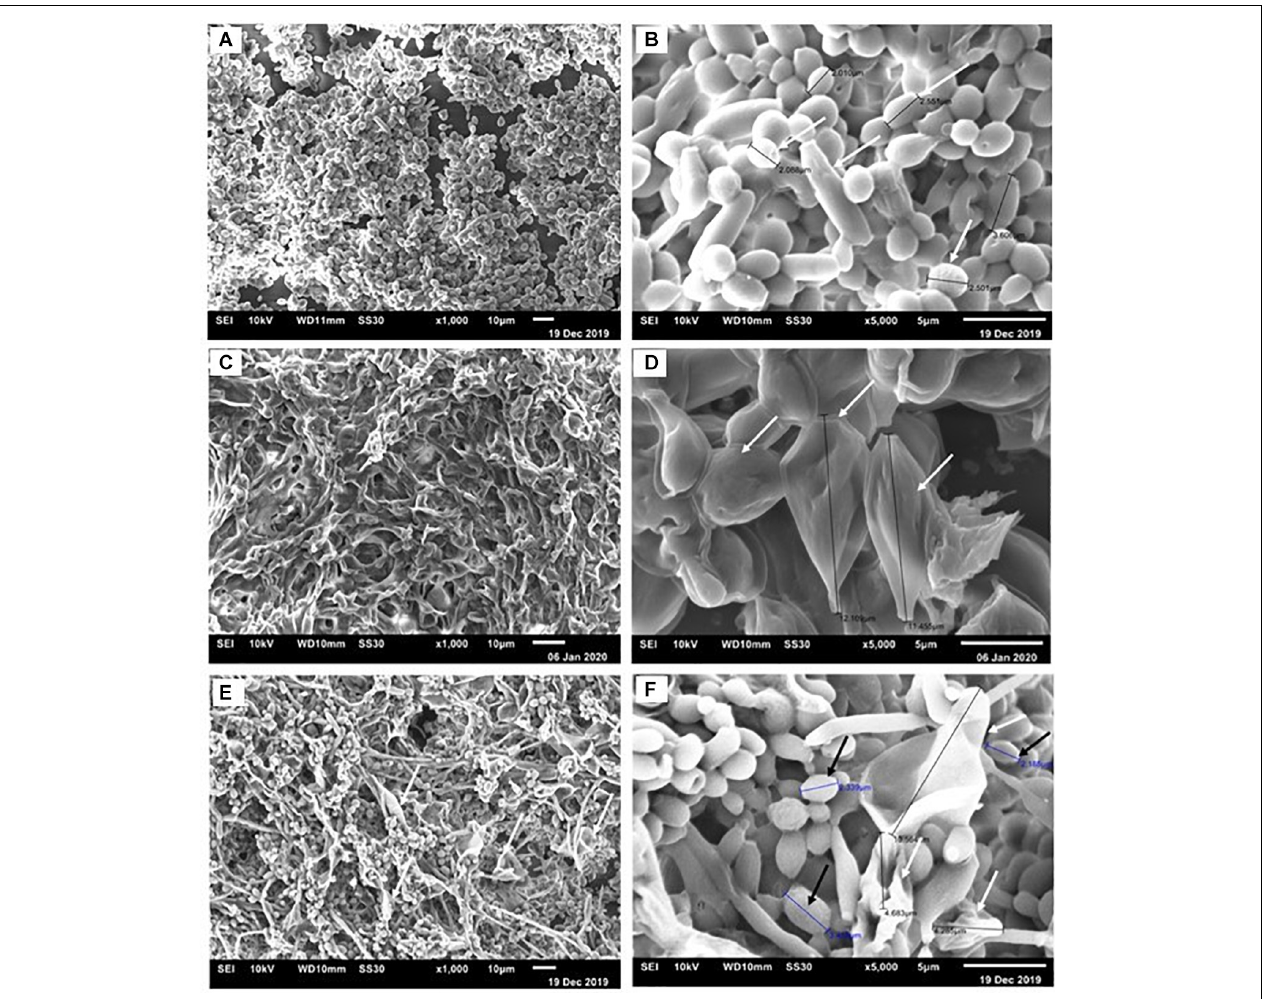
FIGURE 5 | Representative scanning electron micrographs of C. albicans and P. brasiliensis mono-species biofilms formed for 48 and 144 h, respectively. For dual-species biofilms, P. brasiliensis was added to 12 h preformed C. albicans biofilm for 120 h. Biofilms formed by C. albicans (A) 1,000 × and (B) 5,000 × magnification. The white arrows indicate the yeast size (B) . Biofilms formed by P. brasiliensis (C) 1,000 × and (D) 5,000 × . The black arrows denote the measure of yeast (D) . Dual-species biofilms grown from P. brasiliensis added to 12 h preformed C. albicans biofilms (E) 1,000 × and (F) 5,000 ×